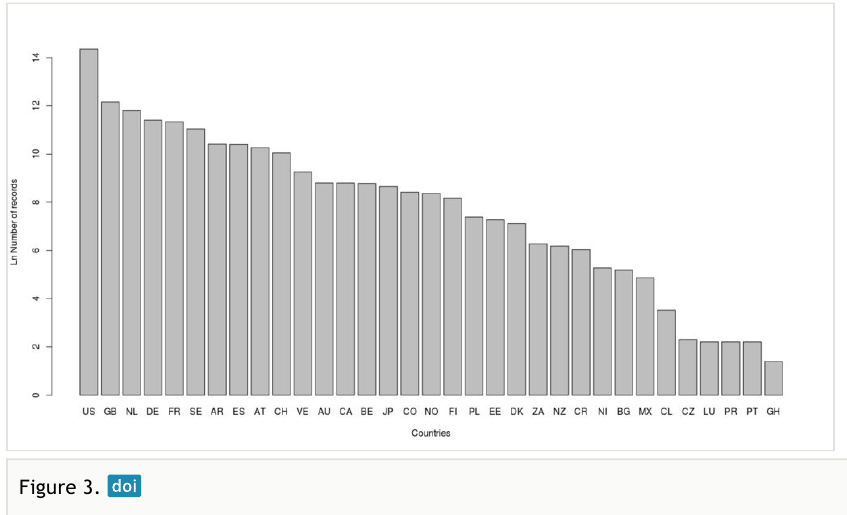
Figure 3. Number of Brazilian records per country published outside national borders (Logarithmic scale). US = United States of America; GB = United Kingdom; NL = Netherlands; DE = Germany; FR = France; SE = Sweden; AR = Argentina; ES = Spain; AT = Austria; CH = Switzerland; VE = Venezuela; AU = Australia; CA = Canada; BE = Belgium; JP = Japan; CO = Colombia; NO = Norway; FI = Finland; PL = Poland; EE = Estonia; DK = Denmark; ZA = South Africa; NZ = New Zealand; CR = Costa Rica; NI = Nicaragua; BG = Bulgaria; MX= Mexico; CL = Chile; CZ = Czech Republic; LU = Luxembourg; PR = Puerto Rico; PT = Portugal; GH = Ghana